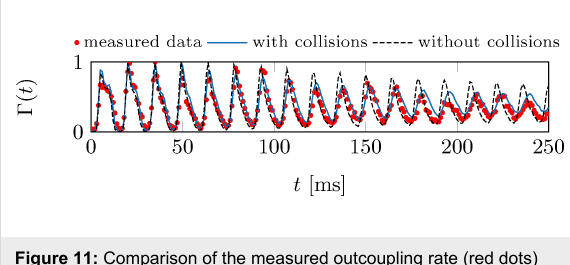
Figure 11: Comparison of the measured outcoupling rate (red dots) and the simulated rates, as derived from a full numerical simulation in- cluding (blue line) and excluding (black line) particle collisions. The outcoupling rates are normalized and derived at an outcoupling posi- tion y 0 = 22.7 μ m ( Δ = 2 π × 1.98